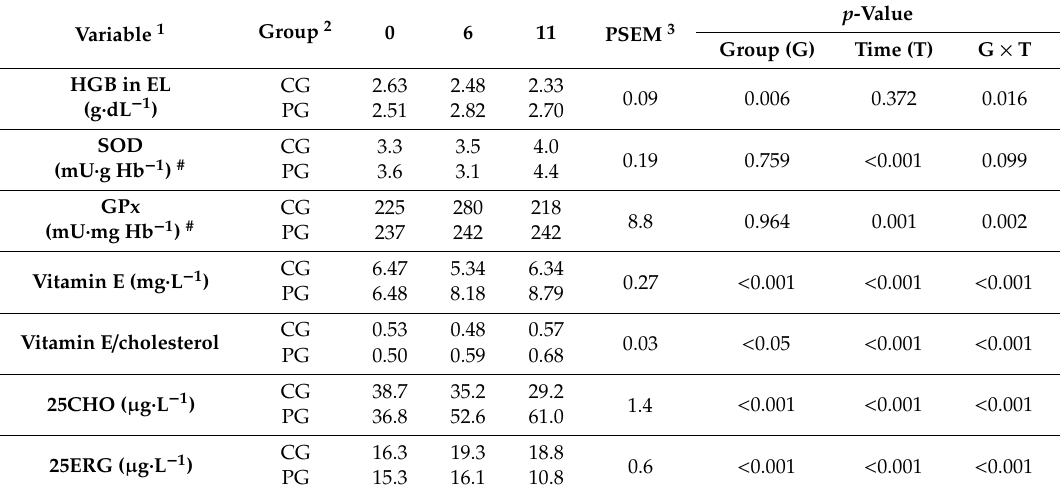
Table 7. E ff ects of a ration change from an indoor based TMR to pasture on blood